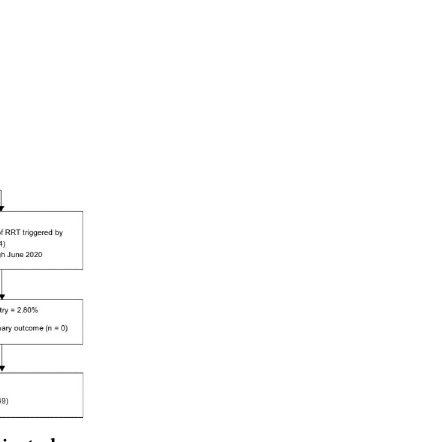
Fig 2. Flow diagram showing the patients included in this